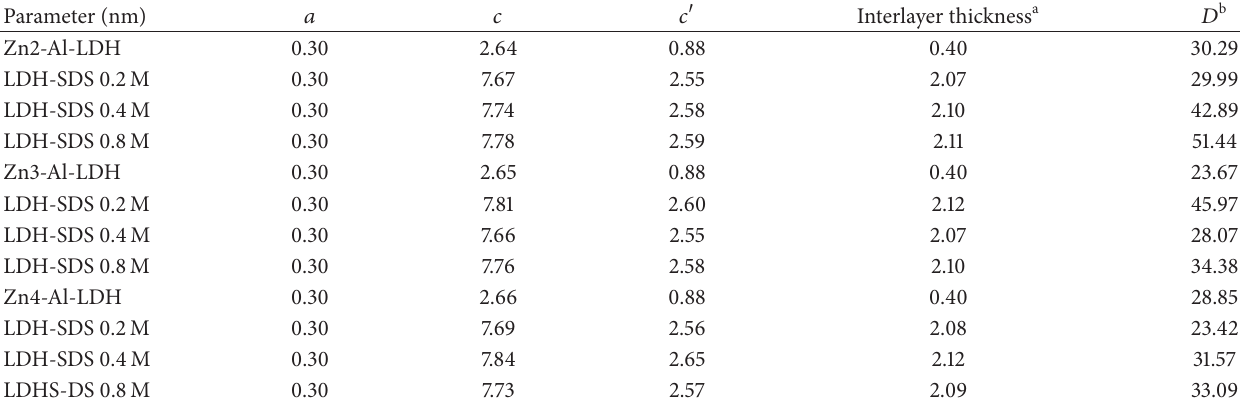
Table 1: The indexing and lattice parameters ( 𝑎 , 𝑐 , and 𝑐 󸀠 ) of the PXRD for the Zn r Al-LDH and LDH-SDS with different concentration of SDS.